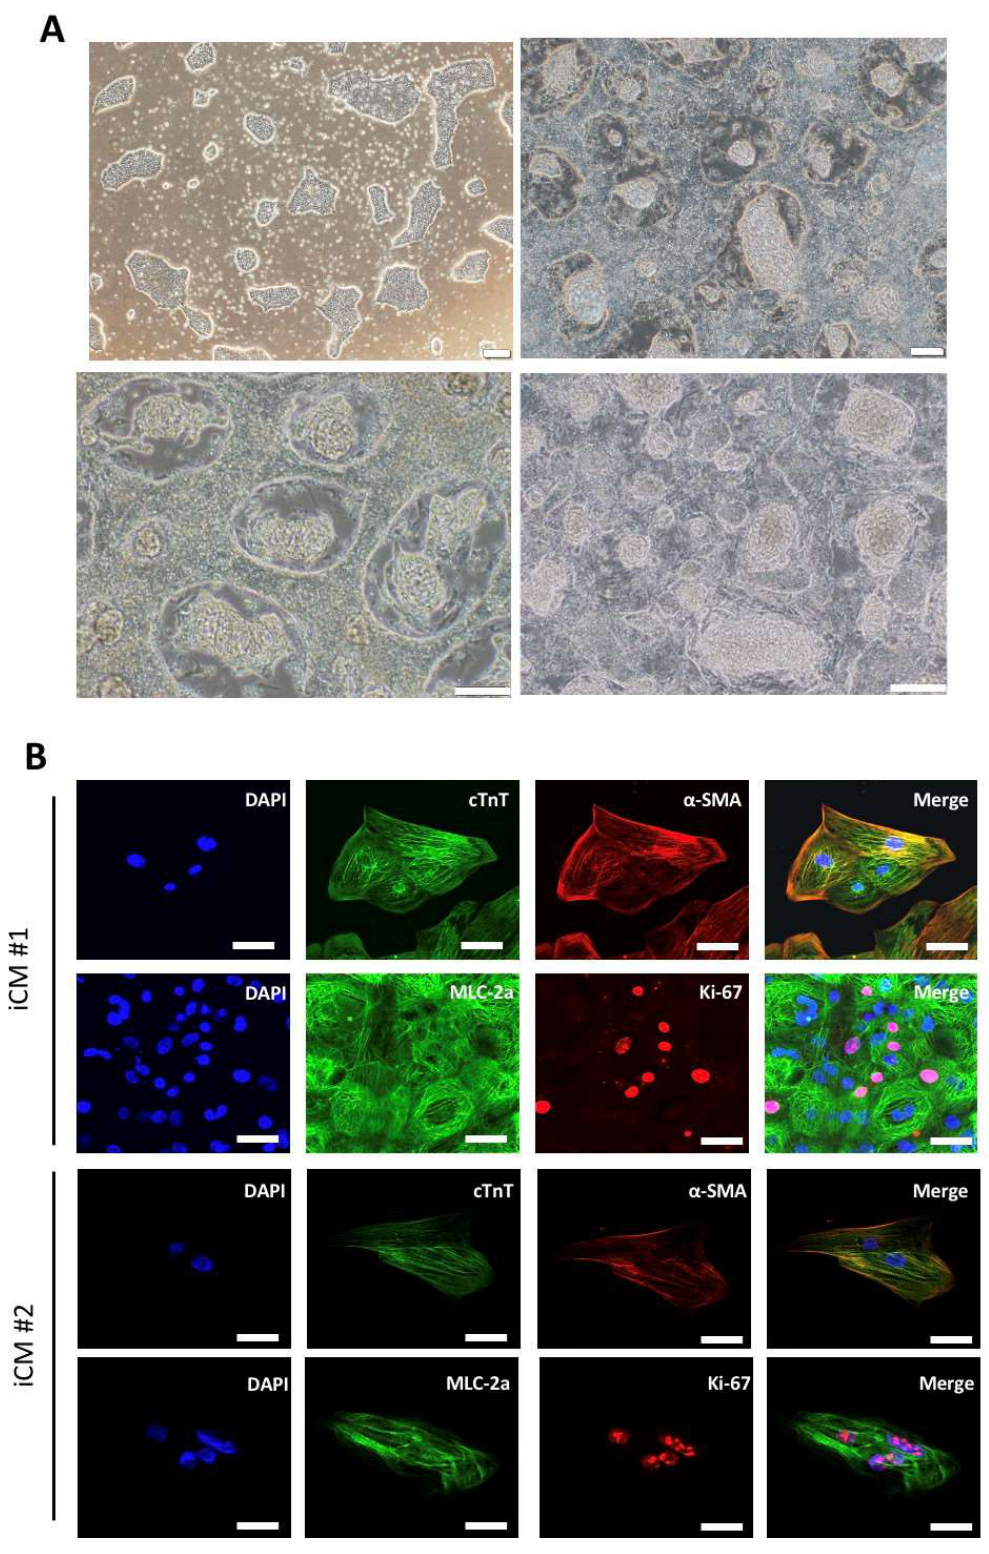
Figure 2. Generation of iCMs after the cardiac induction. ( A ) Distinct cell morphologies during the cardiac induction were shown: hiPSCs (upper left); iCMs (post-induction D12; upper right and lower left); iCMs (post-induction D16; lower right). Scale bar = 200 μm (Upper left) or 100 μm (Upper right, lower left, and lower right). ( B ) Immunofluorescence staining showed the expression of cTnT, α-SMA, MLC-2a, and Ki-67 in iCMs in two generated iCM clones. Scale bar = 20 μm.